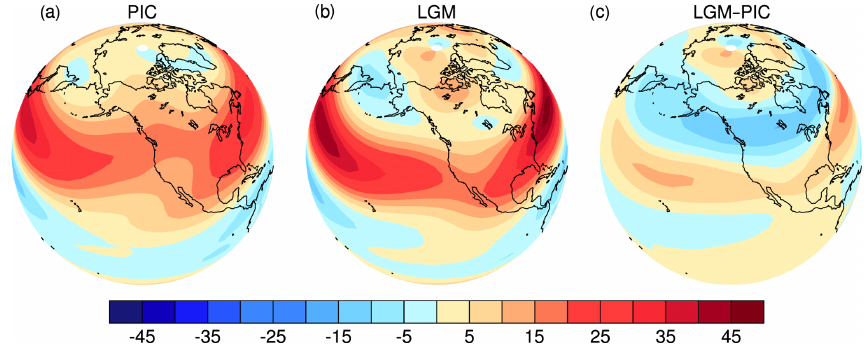
Figure 5. Maps of 500hPa zonal winds in DJF in PMIP2 CCSM3 simulations. (a) PIC, (b) LGM and (c) LGM–PIC. Color interval: 5ms − 1 .